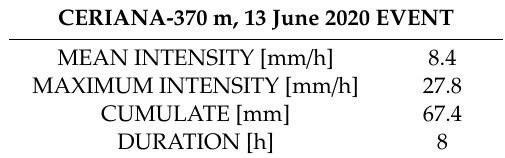
Table 8. Characteristics of the 13 June 2020 rainfall event.